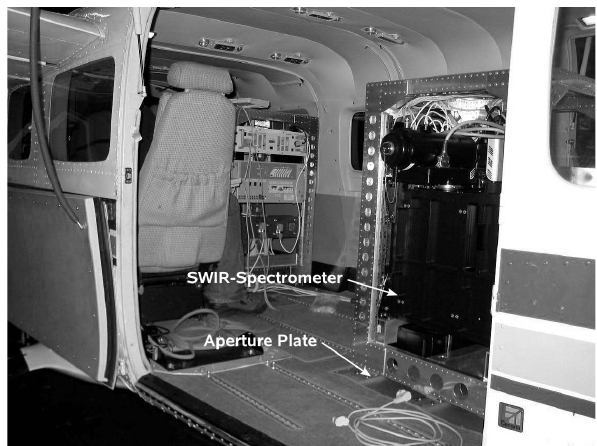
Fig. 4. The MAMAP spectrometer rack mounted on the aperture- plate (front) carrying the optics and the spectrometer systems and the MAMAP auxiliary rack (back) carrying the controllers, power converters and the buffer battery (both racks mounted on the RWE Cessna caravan